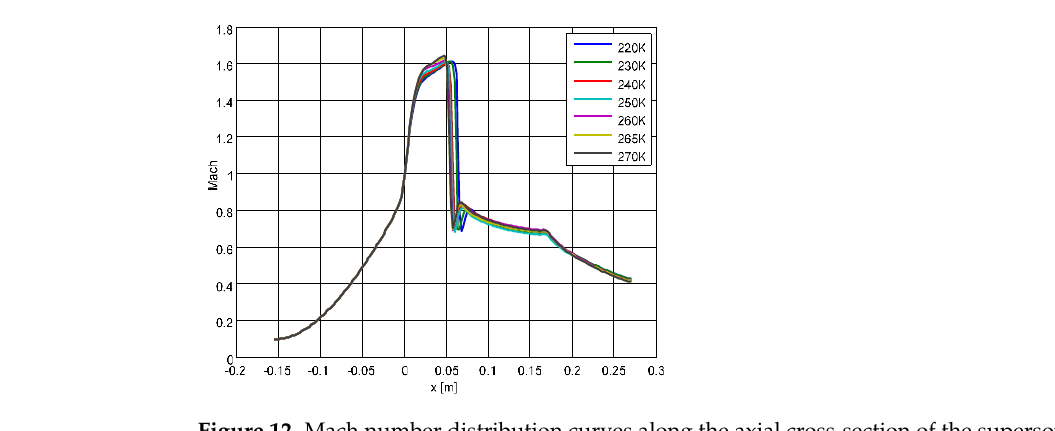
Figure 12. Mach number distribution curves along the axial cross-section of the supersonic separator at temperatures 220, 230, 240, 250, 260, 265, and 270 K.